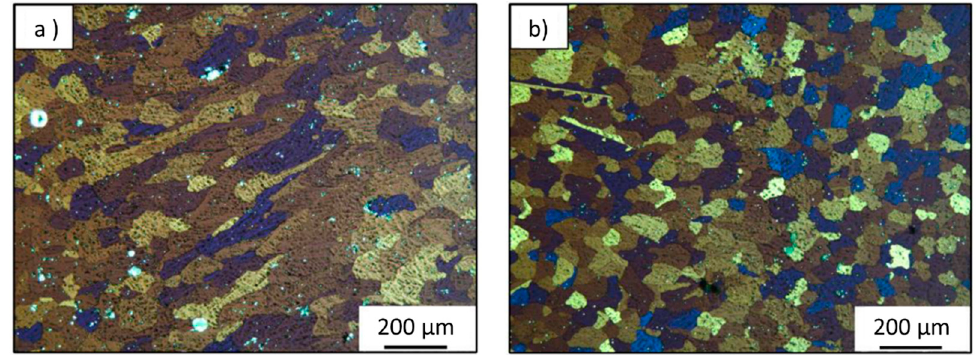
Figure 16. Microstructure of 5363 aluminum alloy: ( a ) as-built and ( b ) with Ti additions [86].